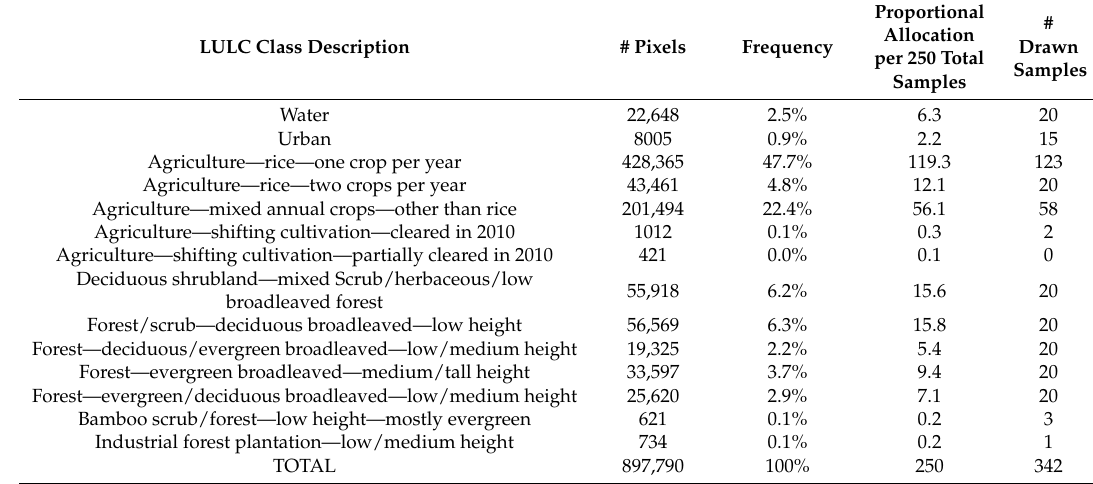
Table 1. 2010 LULC class frequency versus samples drawn per class for the SB 7 final